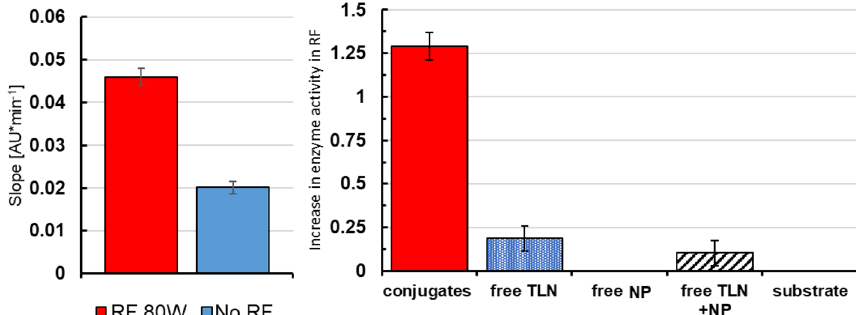
Figure 2. Left side shows RF at 80w vs activity at the same temperature 17 °C without RF field. TLN is an abbreviation for thermolysin. Right side shows control experiment with y axis representing activity increase over bulk in RF. Error bars represent standard deviation of four replicates.